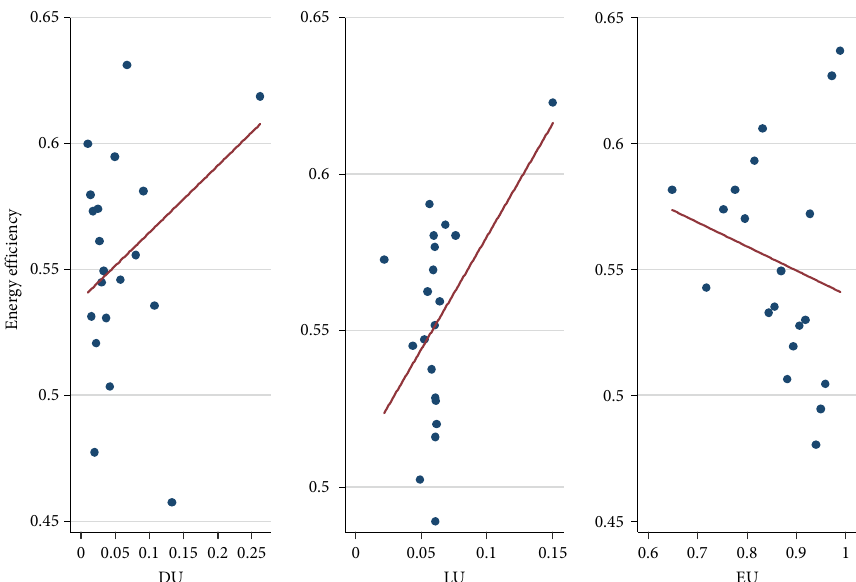
Figure 2. Correlation between urbanization and energy